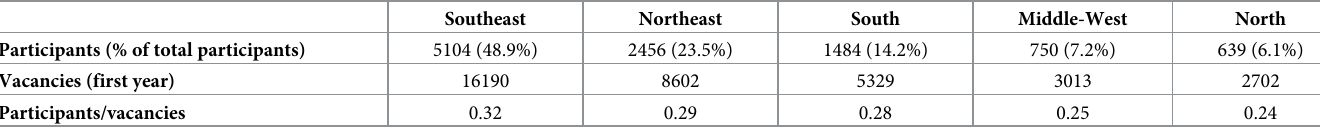
Table 1. Participant distribution according to geographic region of